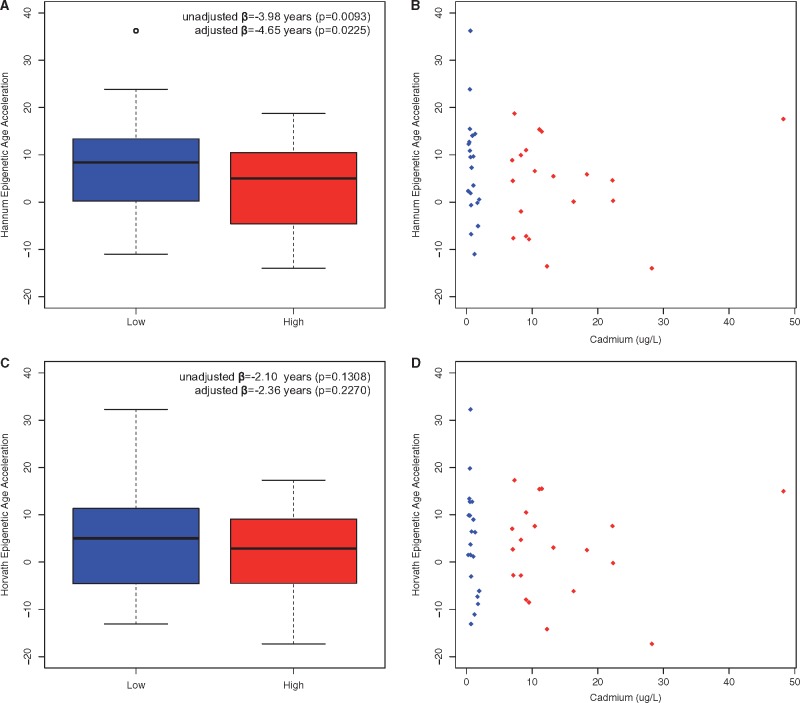
epigenetic age acceleration (Δage). Epigenetic age acceleration (Δage) is calculated as the difference between adjusted DNAm-age and chronologic age. Boxplots of Δage are presented for Hannum (A) and Horvath (C). Relationship between Cd (µg/l) and Δage are presented for Hannum (B) and Horvath (D). Blue and red denote LE and HE group, respectively